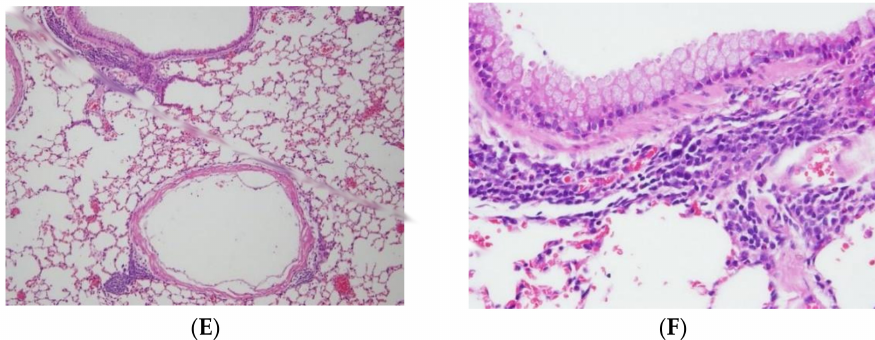
Figure 3. Histopathological findings of lungs were found in the OVA-induced bronchiolitis in mice. Lungs are shown as focal inflammatory cell infiltration, mainly neutrophils, lymphocytes, and (fairly) eosinophils, around perivascular and peribronchial spaces, which were, respectively, graded as slight (2) in the ML group (( A , B ), ML3-1), MM group (( C , D ), MM5-1), and minimal (1) in the MH group (( E , F ), MH3-1), H&E stain; 100 and 400 × .